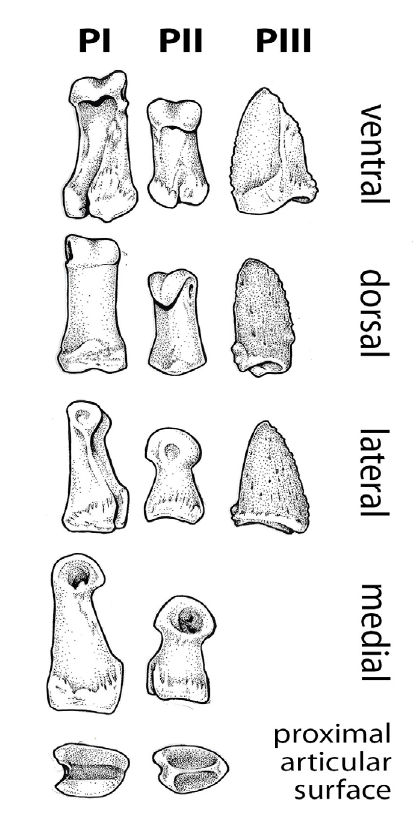
Figure 2. PI, PII, and PIII depicted from multiple an- gles, in reverse anatomical position. As each hoof con- tains two digits, and as the differentiation between the analogous digit of the opposite hoof cannot yet be quantified, each hoof will be presented as the en- tire subject of study, rather than the entire body of the animal. For this reason, it is important to clarify directional terminology. Medial and lateral sides are designated as medial and lateral to the center of the hoof, not to the animal’s body. Thus, the medial side of a phalanx would be the side that faces the center of the hoof, towards the other digit of the same hoof. (Both illustrations depict right limb bones, although it should be noted that at this time there is no ac- curate test for determining right-limb from left-limb phalanges). Illustration by